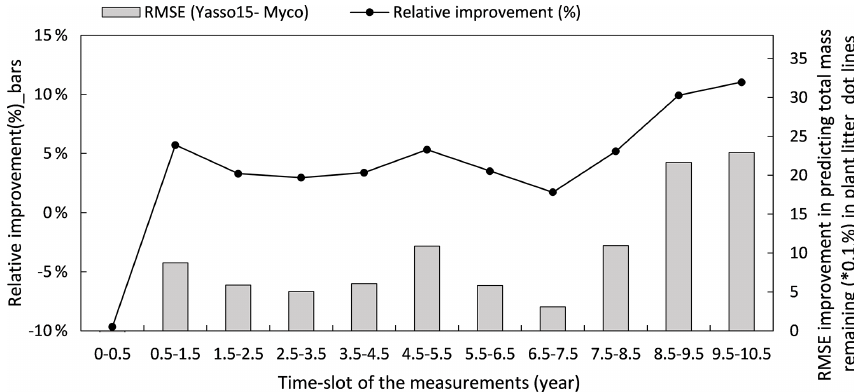
Figure 8. Improvement of performance comparing the Myco-Yasso model to the original Yasso model over the decomposition period. Bars represent the relative RMSE differences between Yasso15 and Myco-Yasso per period. The line with dots shows the absolute value of the RMSE differences (Yasso15- Myco). Predictions examined from the full dataset